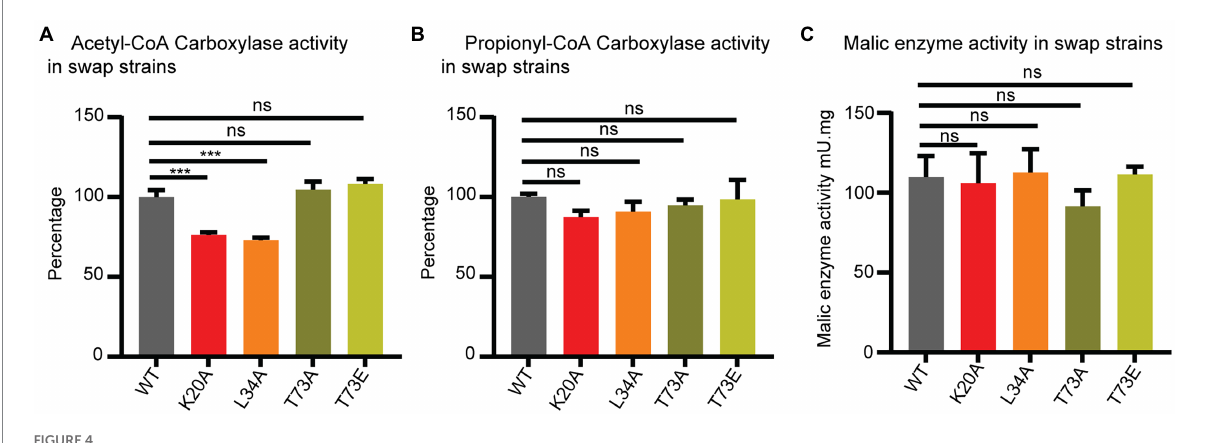
FIGURE 4 Wag31 modulates ACC activity. ACC (A) , PCC (B) and malic enzyme (C) activity in cell-free extracts of Msmeg expressing WT or wag31 mutants. Results are the means of three independent experiments ± standard deviations ( n = 3). ns, p > 0.05, *** p = <0.0005. All p -values were calculated by Tukey’s multiple comparison